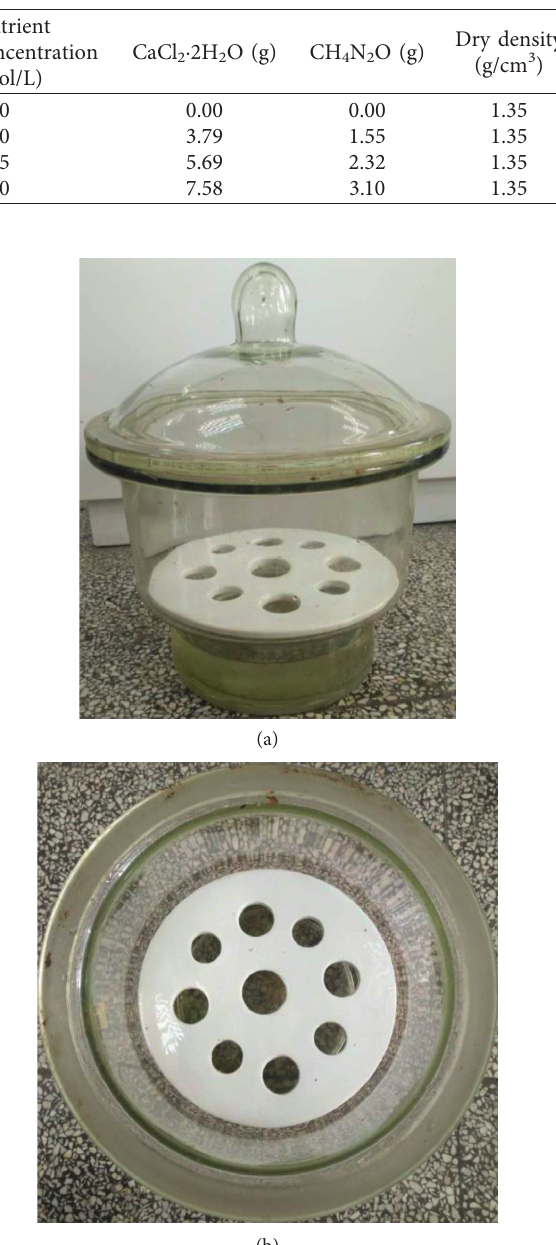
Figure 3: Moistening cylinder for curing